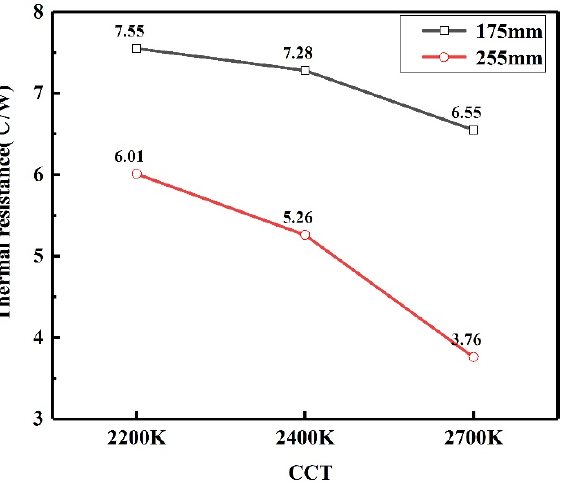
Figure 5. Thermal resistance curves of filaments of two different lengths (175 mm, 255 mm) at different color temperatures (2200 K, 2400 K, 2700 K). Table 2. Proportion of phosphor color.